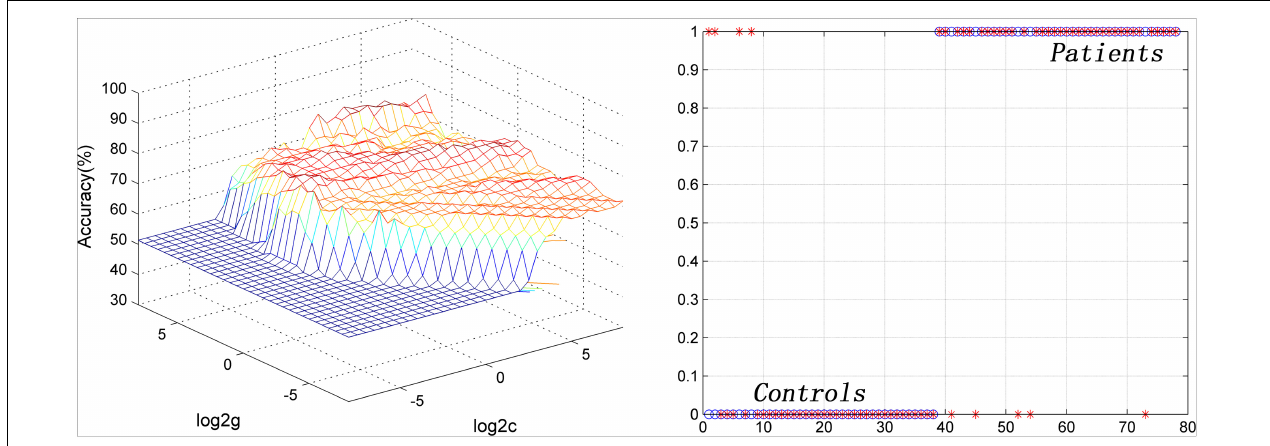
FIGURE 4 | Visualization of SVM classification by using PAS scores in the bilateral middle cingulate cortex to differentiate patients with OCD from HCs. Left: 3D visualization of SVM with the best parameters; right: classification map of the PAS values of the bilateral middle cingulate cortex. SVM, support vector machine; PAS, parameter of asymmetry; OCD, obsessive-compulsive disorder; HCs, healthy